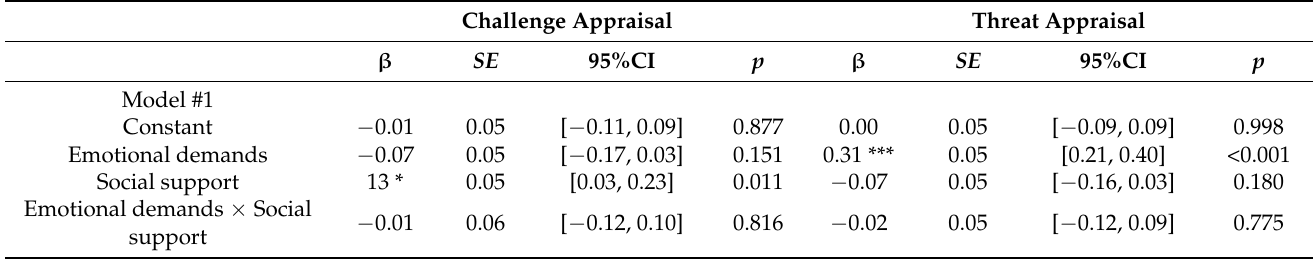
Table 5. Linear model of predictors of nurses’ challenge and threat appraisal of emotional demands.